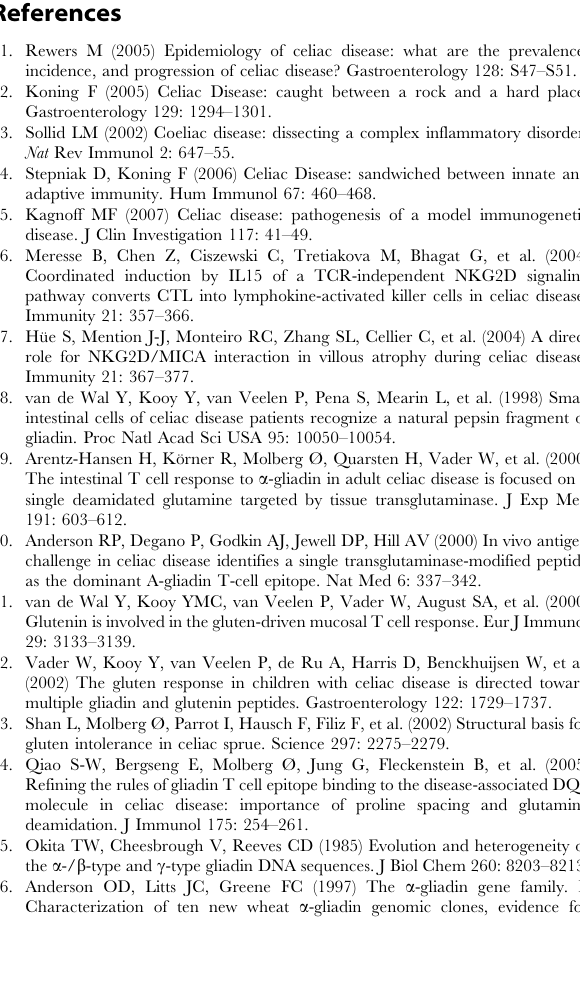
Figure S3 DQ2-Glia- a 1 variants. The effect of various amino acid substitutions on the ability of the DQ2-Glia- a 1 peptide to stimulate DQ2-Glia- a 1 T cells. Table S1 Amino acid sequences of the DQ2-Glia- a 1/- a 2/- a 3 region of a -gliadin cDNA transcripts from three diploid T.monococcum accessions (diploid, AA genome).